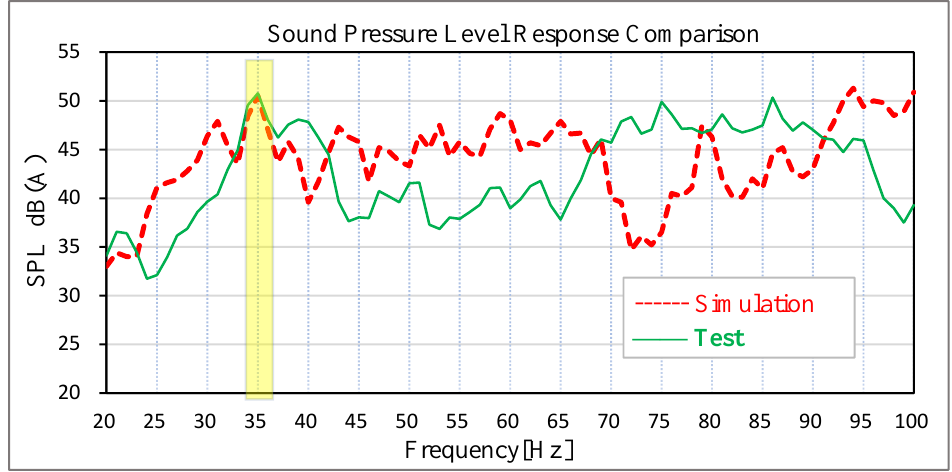
Figure 11. Comparison of test results and simulation results of passenger’s right ear noise